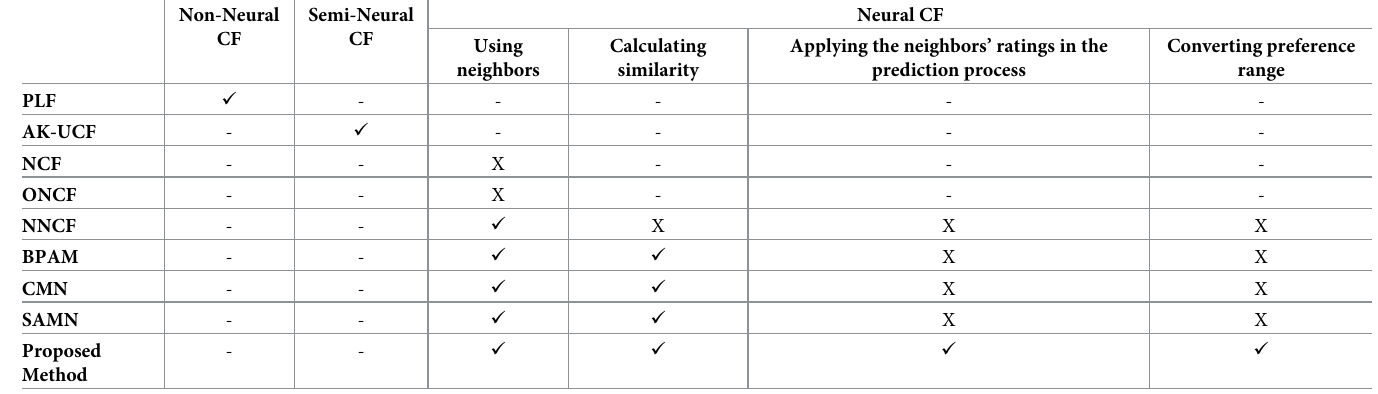
Table 1. Comparison of the related works with respect to the neighbor